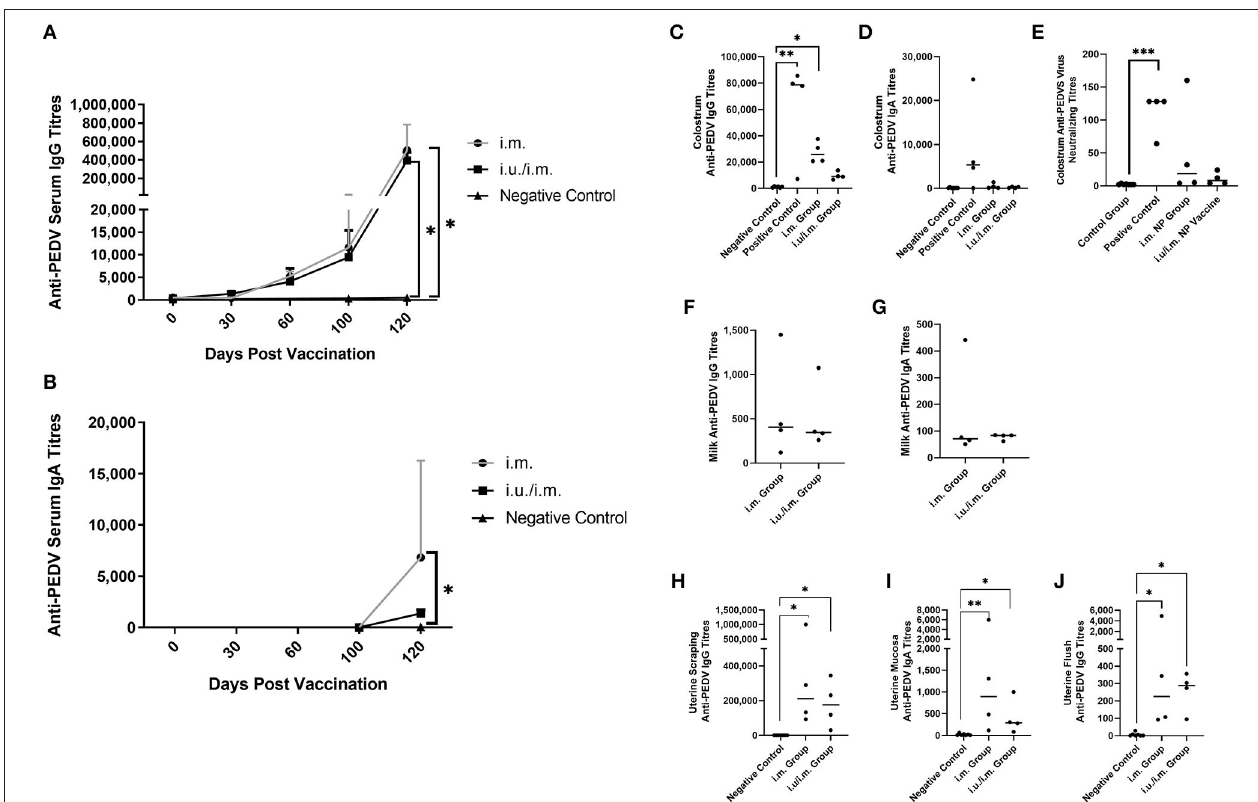
FIGURE 1 | Serum and mucosal antibody titers from animals vaccinated through the intramuscular route with or without prior intrauterine vaccination. Serum IgG (A) and IgA (B) antibody titers were collected over time from gilts immunized with PEDVS1-NP 30 days after estrus (i.m. group) and from gilts immunized via the intrauterine route at breeding and followed by an i.m. vaccine 30 days later (i.u/i.m. group). Negative control gilts did not receive any vaccine. Positive control gilts were previously immunized with a live attenuated PEDVS1 vaccine and showed passive protection for piglets. IgG and IgA antibodies from colostrum [IgG and (C) ; IgA and (D) ], colostral virus neutralizing antibodies [IgG and (E) ], and mature milk [IgG and (F) ; IgA and (G) ] were collected on the day of birth for colostrum and on day 6 for milk. At 9 days after farrowing, the uterine tissue was minced, and the mucosal antibodies were collected 48h later to quantify uterine mucosal antibodies [IgG, (H) ; IgA and (I) ], and the uterine luminal antibodies were collected at the time of tissue harvest after 50ml flush with PBS [IgG and (J) ]. Data are presented as median and standard deviation. Statistical analysis was carried out by the Kruskal-Wallis test and Dunn’s multiple comparisons test. Significant differences relative to the negative control gilt data are denoted by different asterisks ( * p < 0.05, ** p < 0.01, *** p <